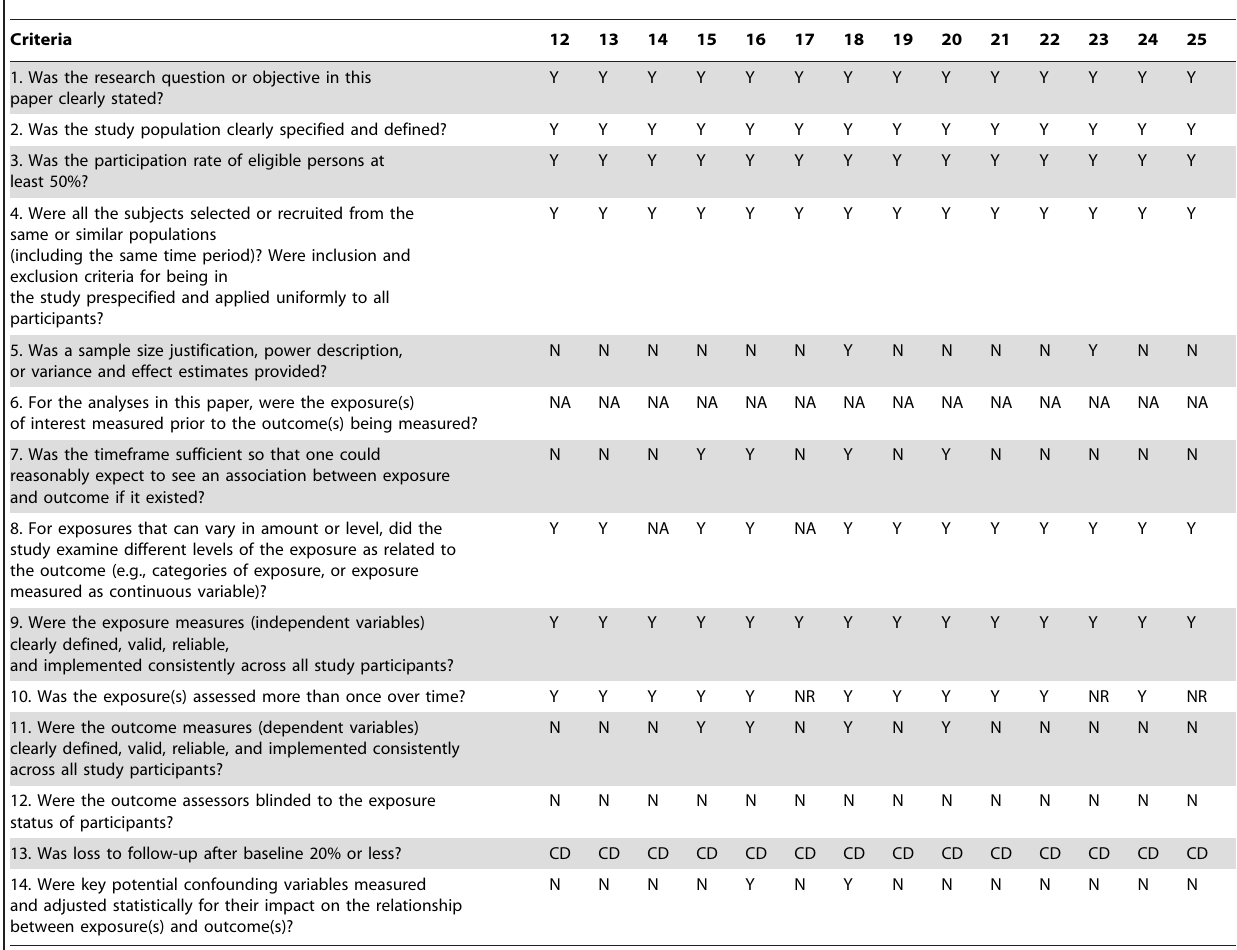
Table 1. Quality Assessment Tool for Observational Cohort and Cross-Sectional